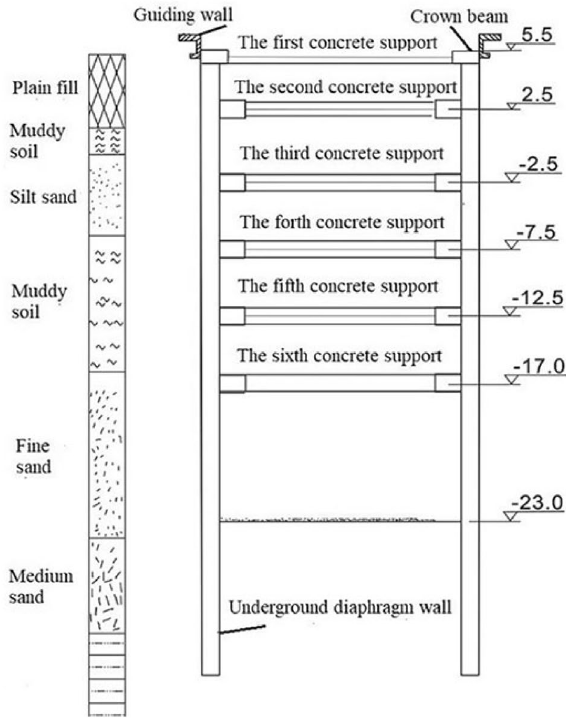
Figure 7. Schematic diagram of soil layer distribution and support